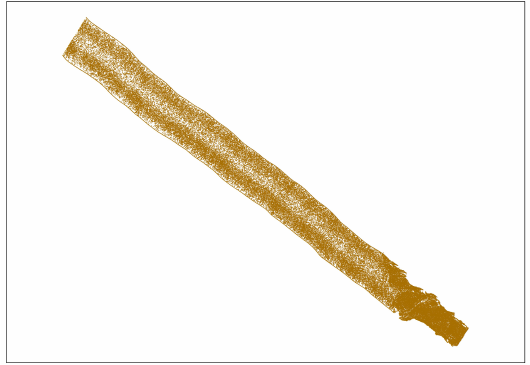
Figure 11. System-based thinning method of 5% thinning rate